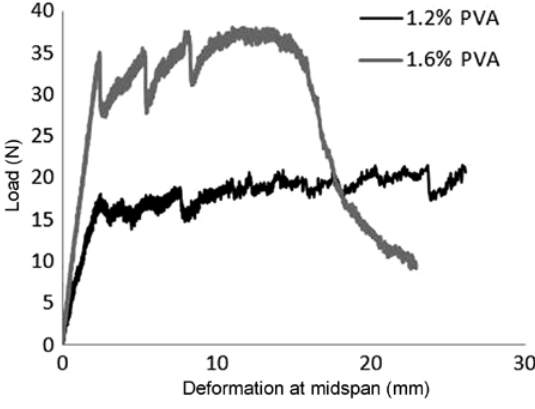
Figure 5 Longitudinal flexural